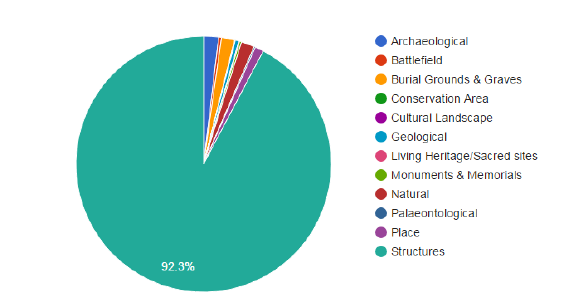
Figure 1: Chart showing the breakdown of declared Provincial Heritage Sites based on site type (SAHRA, 2017e).